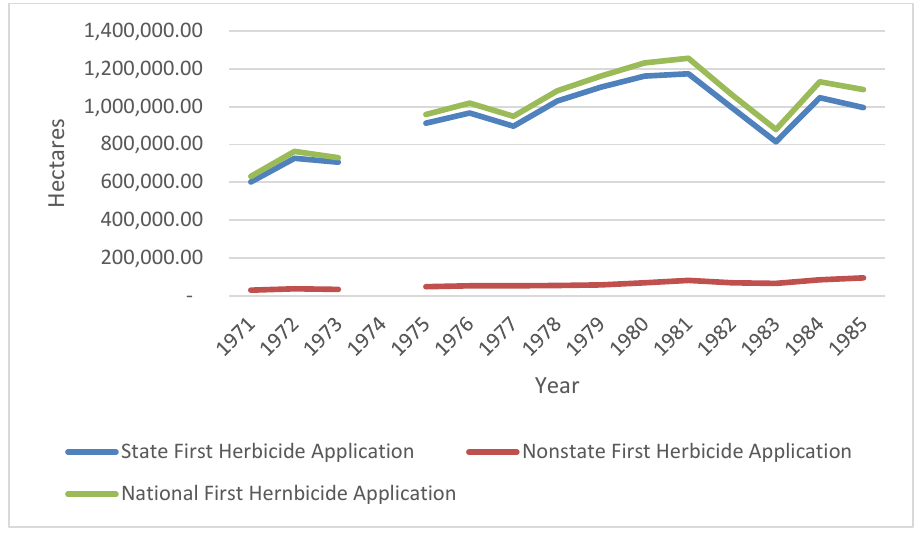
Figure 2. First Herbicide Application in